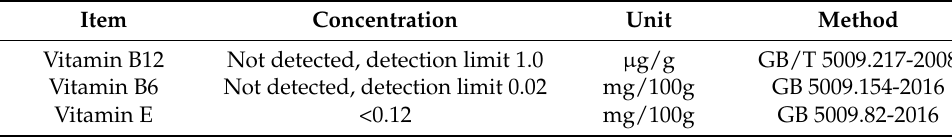
Table 1. The concentrations of VB6, VB12 and vitamin E in Se-FA. Item Concentration Unit Method Vitamin